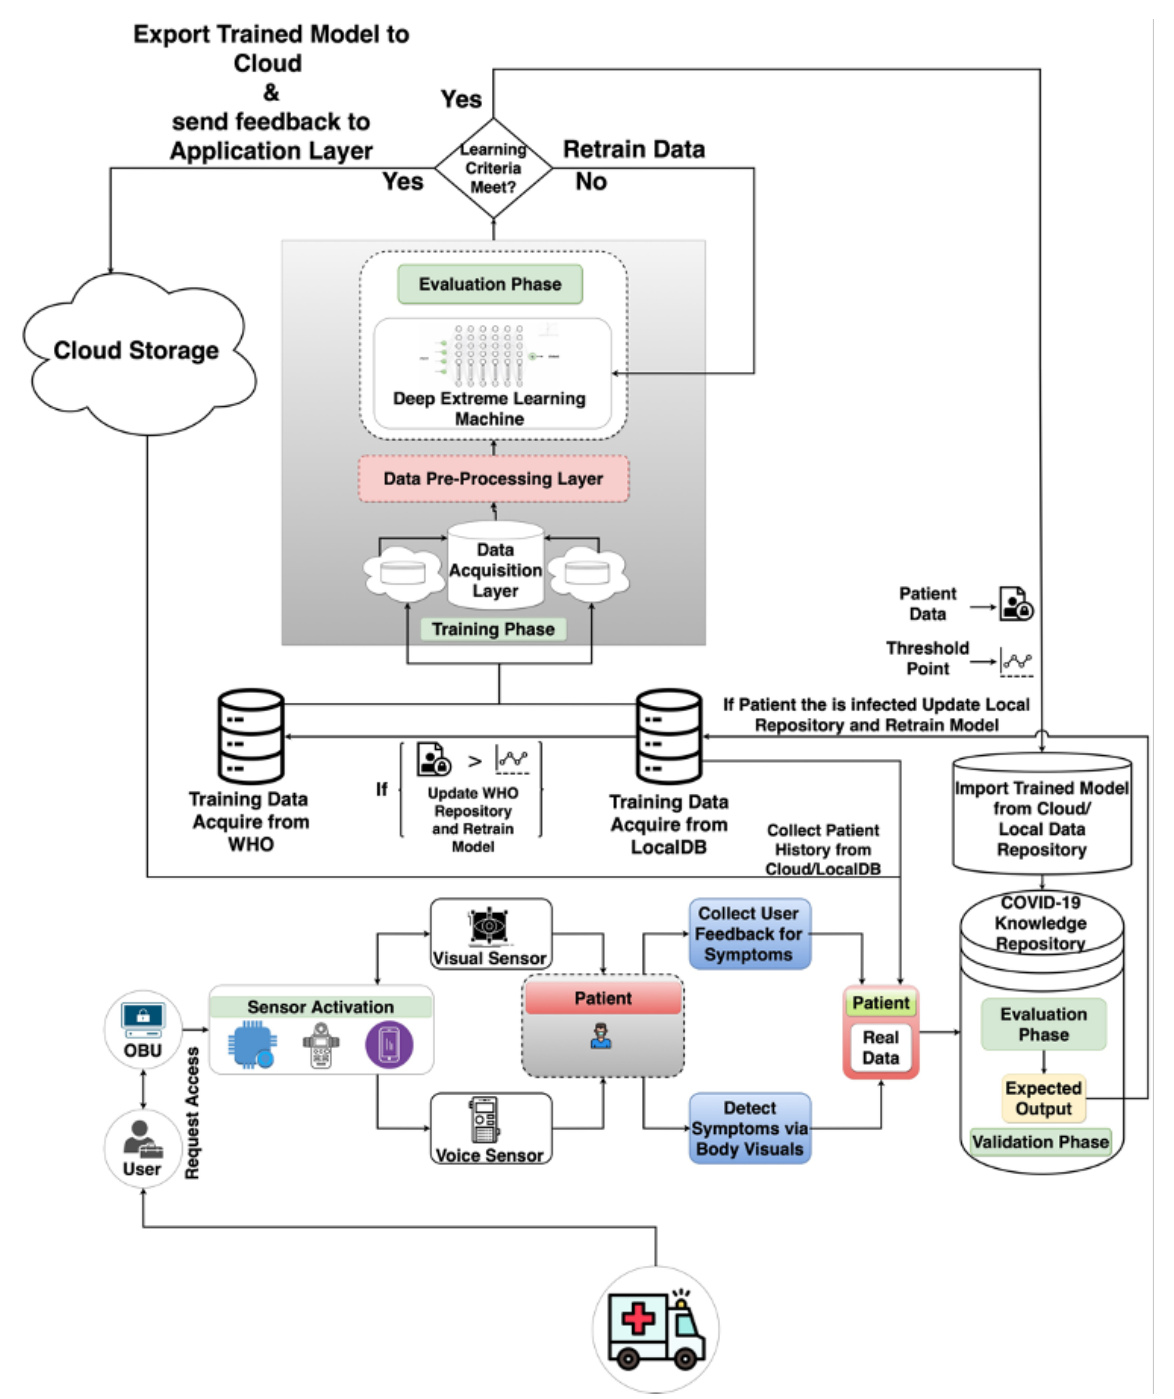
Figure 1. Vehicle-based Approaches to detect individuals with COVID-19